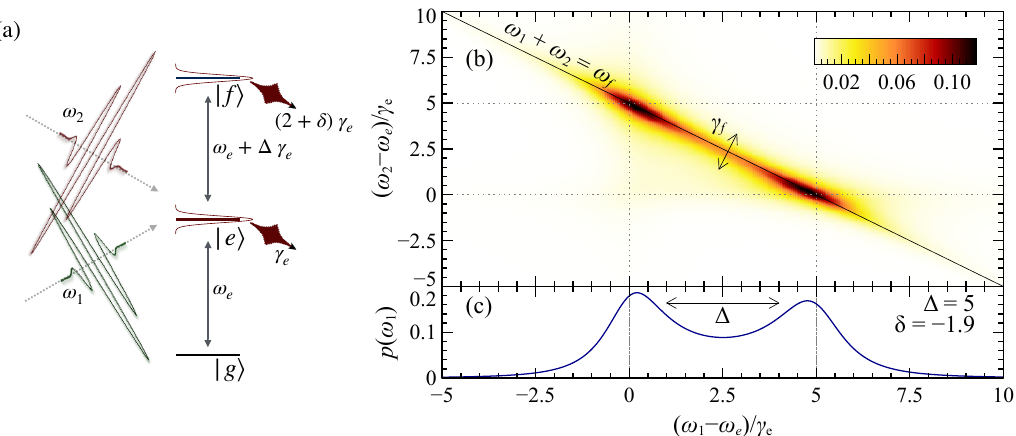
Figure 1: (a) A two-photon transition from ground state | g 〉 to target state | f 〉 , via intermediate state | e 〉 , is driven by two incoming, near-resonant single-photon pulses with carrier frequencies ω and ω , respectively. The excitation efficiency is subject 1 2 to finite decay rates of | e 〉 and | f 〉 , the characteristic scale ω of the level spacing, the e detuning ∆ of the individual nearest neighbour level spacings from degeneracy (in units of the intermediate state’s lifetime γ ), the deviation of the excited state decay e rates’ ratio from two (again in units of γ ), see (17), and, here of central interest, e the frequency correlations (see panel (b)) inscribed into the incoming pulses. (b) ( ω ) | 2 ∝ | Φ ( ω ) | 2 of the optimal two-photon wave function (32) Density | T , ω , ω t 1 2 1 2 − ω ) /γ in the space of rescaled frequencies ( ω , and parametrized by detuning j e e ∆ = 5 and deviation δ = − 1.9 as specified in panel (a) and (17). (c) Single-photon density (34) derived from (32) upon tracing over the frequency of the partner photon ) | 2 , for the same parameter values as in panel (b). The double-peaked in | Φ ( ω , ω 1 2 distributions in (b,c) feature maxima in the vicinity of the first ( | g 〉 → | e 〉 ) and second ( | e 〉 → | f 〉 ) bare transition’s (see panel (a)) rescaled frequencies 0 and ∆ , respectively, with distinct widths determined by ∆ and δ , see (33,34). The widths of the local maxima give a qualitative impression of the nonclassical frequency correlation between both incoming